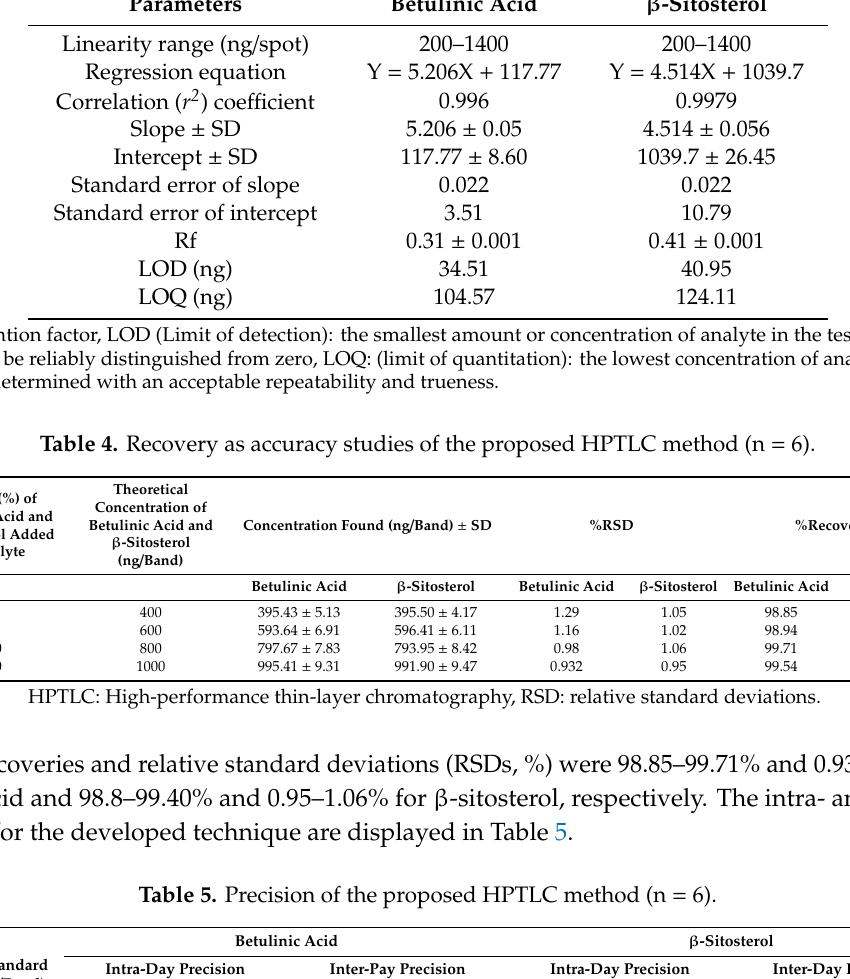
Table 3. Rf, linear regression data for the calibration curve of betulinic acid and β -sitosterol (n = 6). Parameters